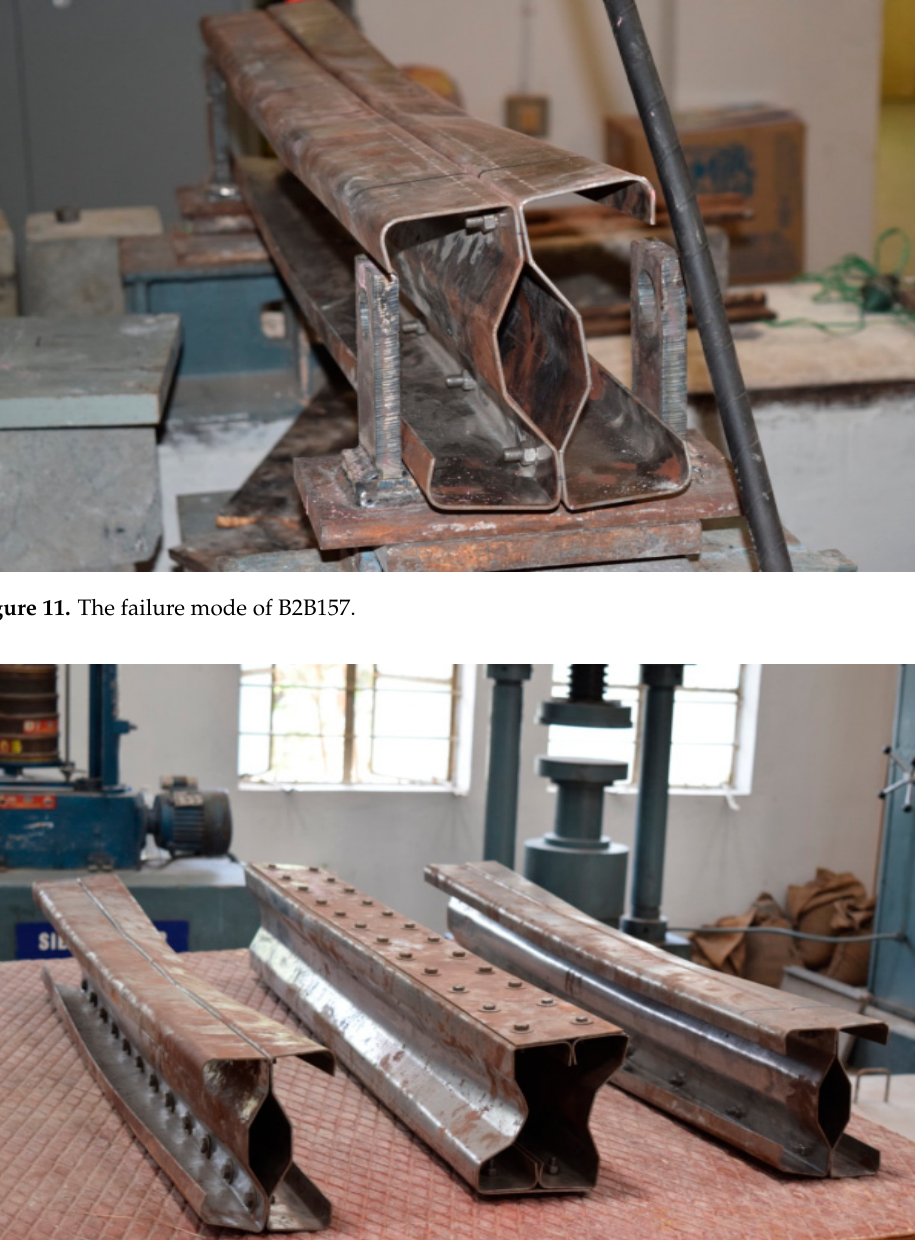
Figure 10. The failure mode of F2F100.